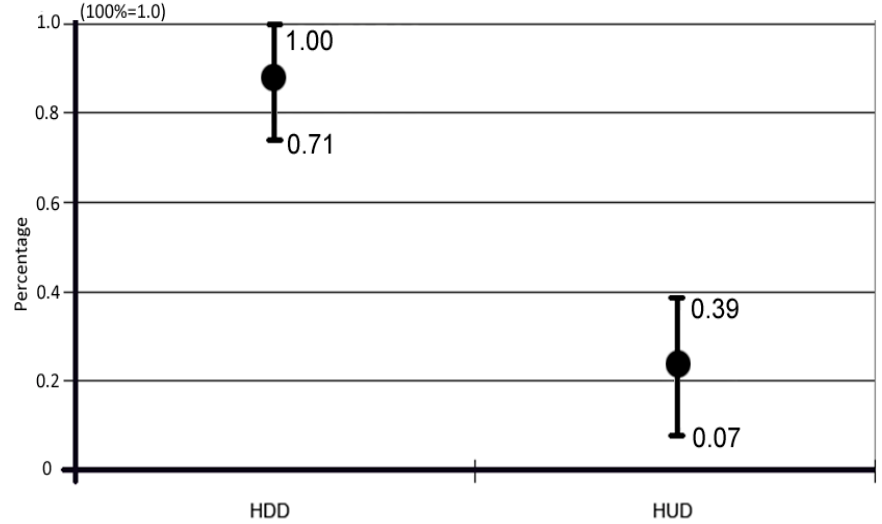
Figure 14. User experience results regarding the ease of use for the HUD interface.